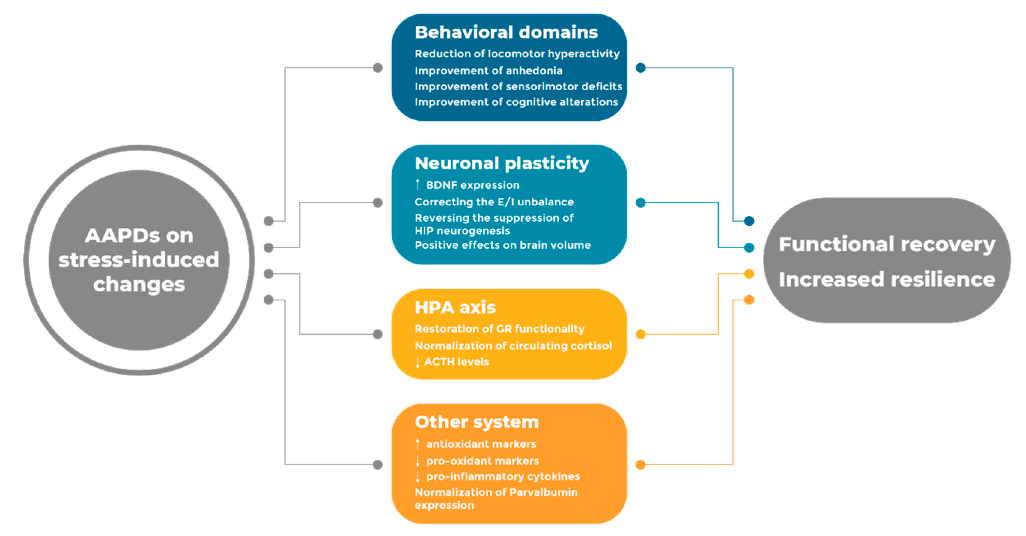
ff ects produced by AAPDs on stress-induced Figure 1. Summary of the major effects produced by AAPDs on stress-induced changes. Figure 1. Summary of the major e